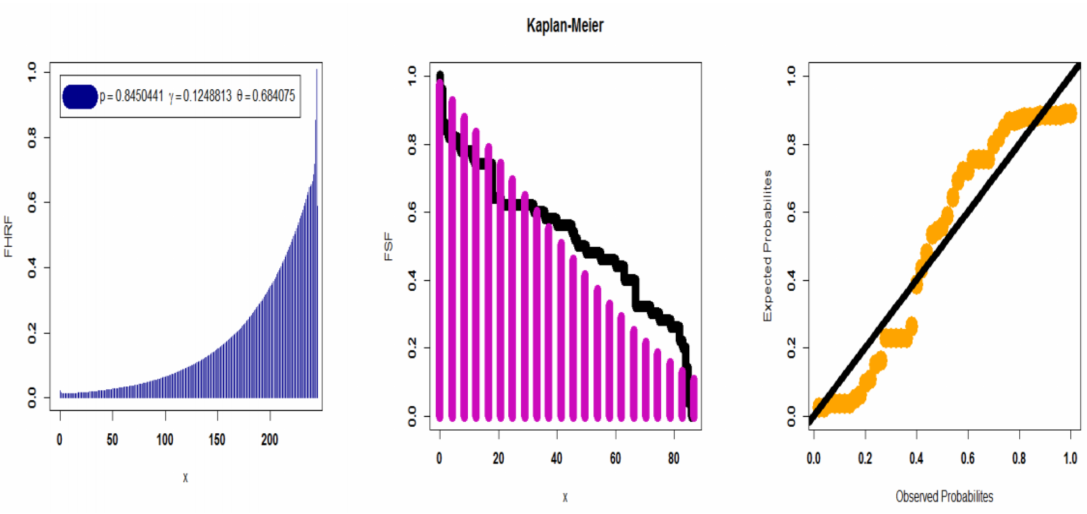
Figure 8. The FHRF, ESF, and P–P plots for dataset